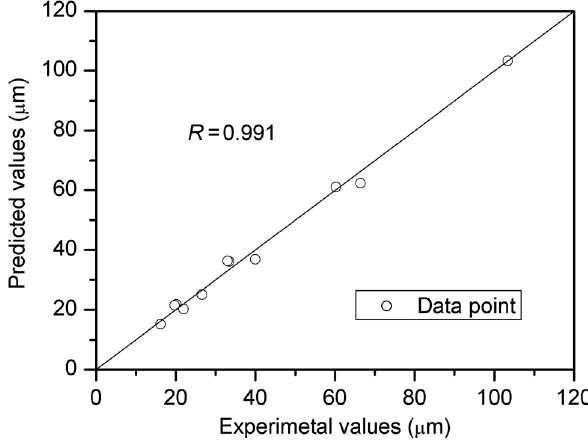
Figure 12: Correlation between experimental grain size of Nimonic 80A and the predicted one from the developed constitutive model.